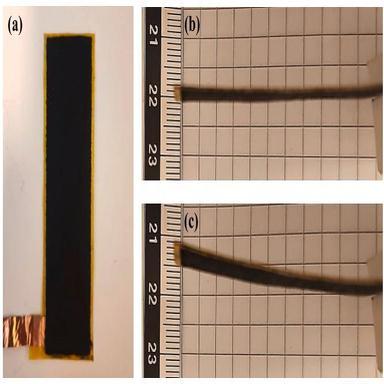
(a) Top view of the soft actuator. (b) The soft actuator is at rest (no electric field is applied). (c) The soft actuator bends when an electric field is applied.